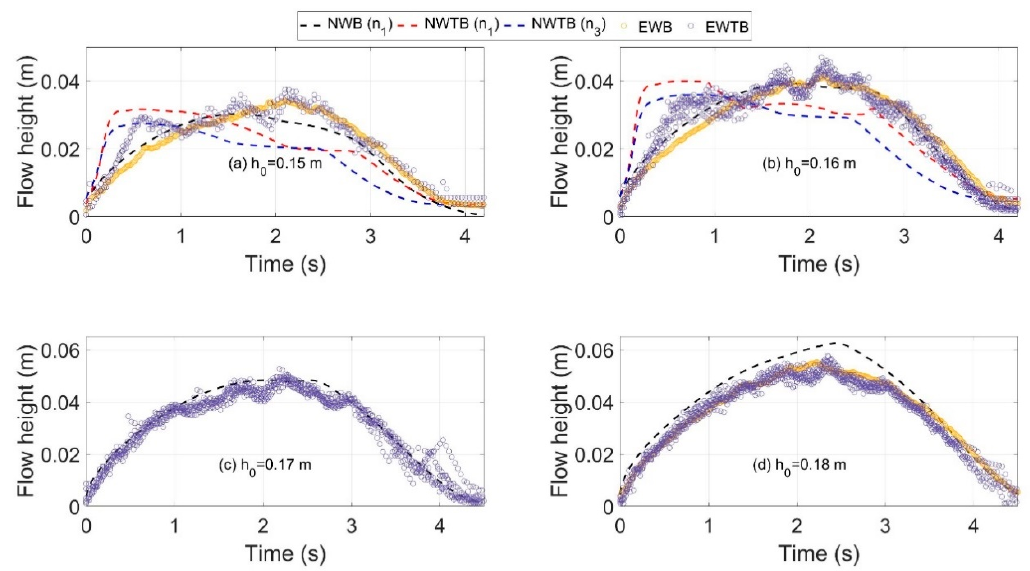
Figure 8. Flow height profiles for the cases with basin level from h 0 = 0.15 m to h 0 = 0.18 m (denoted from ( a ) to ( d )). Here, WB and WTB denote the configuration “without block” and “with the block” respectively. The initial capital ”N” and ”E” denote data from numerical simulations and experiments respectively. The displayed “EWB” data are obtained by averaging the original data sets. NWTB are omitted in plots ( c ) and ( d ), considering that NWB is able to capture the experimental data (the block was initialized soon as can be seen in Table. 1).